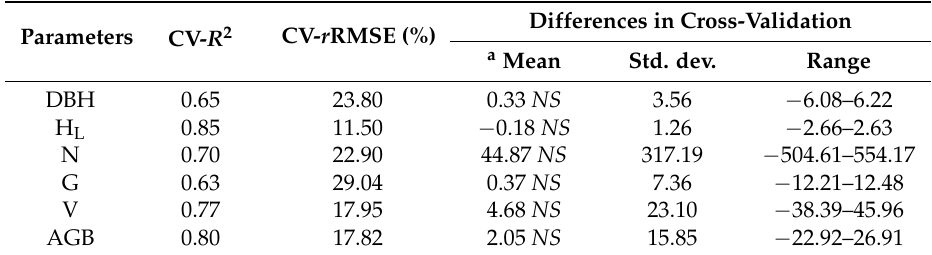
Table 8. The results of cross validation for the forest structural parameters predictive combo models. Parameters CV- R 2 Parameters